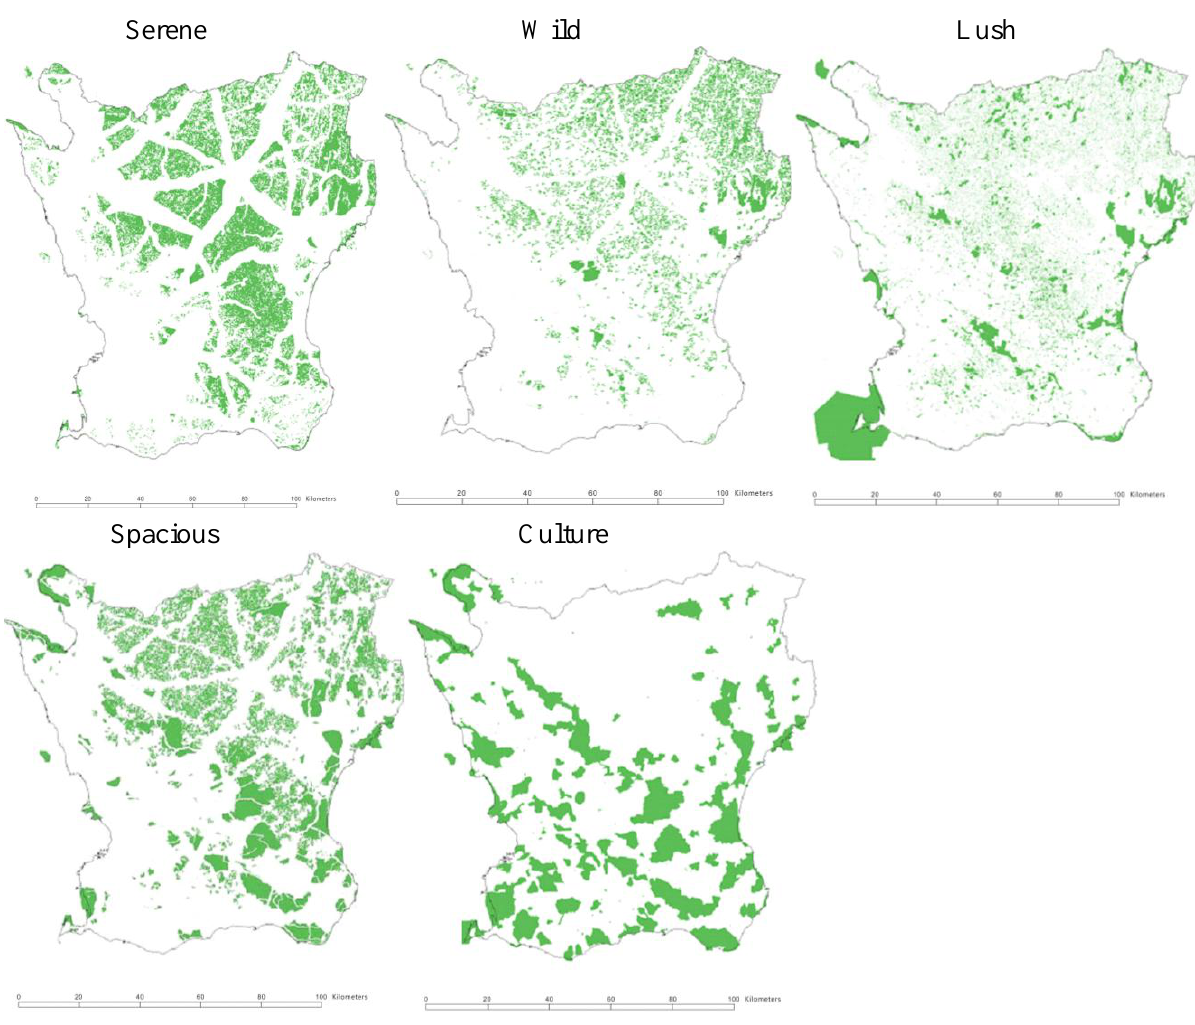
Figure 1. Map over Southern Sweden (county Scania) showing the distribution of five of the nature qualities: Serene, Wild, Lush, Spacious, and Culture.